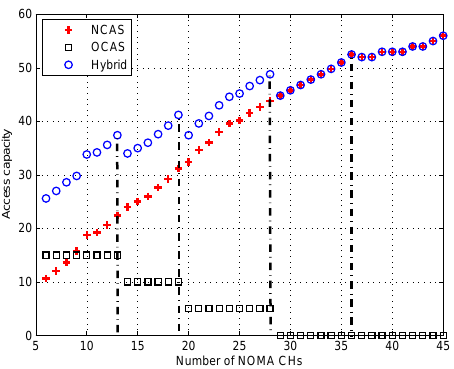
Figure 5. Comparison of the access capacity among the hybrid NOMA-orthogonal frequency division multiple access (OFDMA) , NCAS, and OFDMA-based congestion-alleviating access scheme